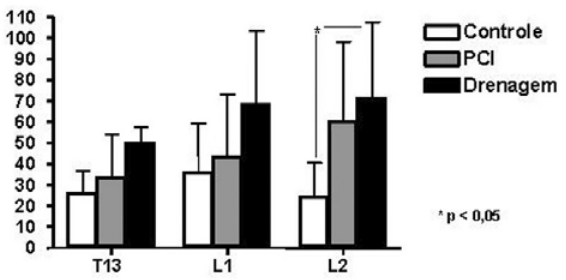
Fig. 6 - Número de neurônios viáveis, nos três grupos, nos níveis T13, L1 e L2. Os valores estão apresentados em média e desvio- padrão